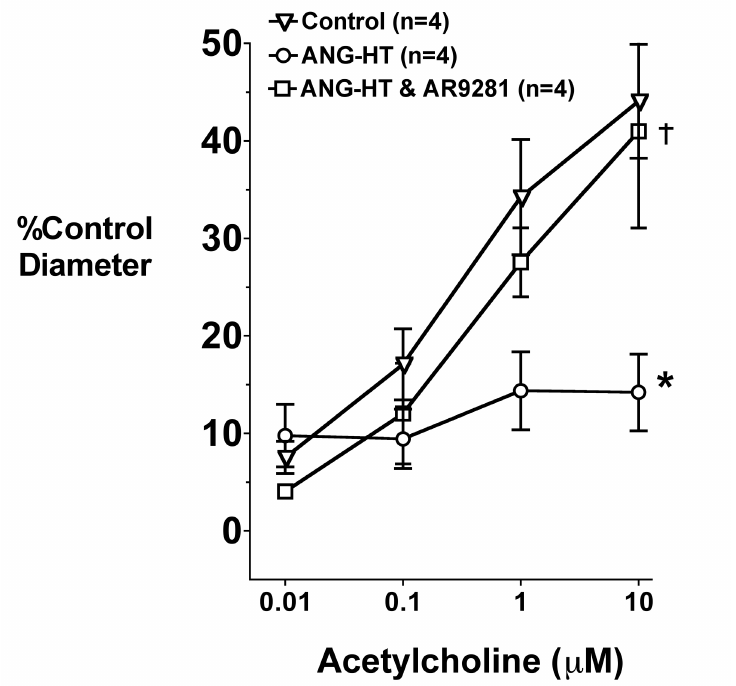
Figure 3. The effect of the sEHI, AR9281 on afferent arteriolar vasodilation in angiotensin-infused rats (ANG HT). Values are mean ± SEM. *Significant difference between control and ANG HT and vehicle groups, = significant difference between ANG HT & vehicle and ANG HT and AR9281